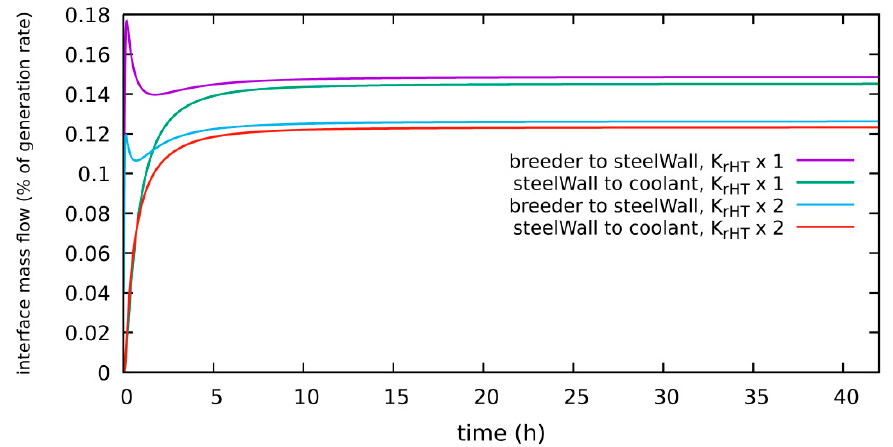
Figure 21. Transient tritium flow through patch interfaces breeder to and from steel, and steel to and from coolant for K = 1 vs. K = 2.